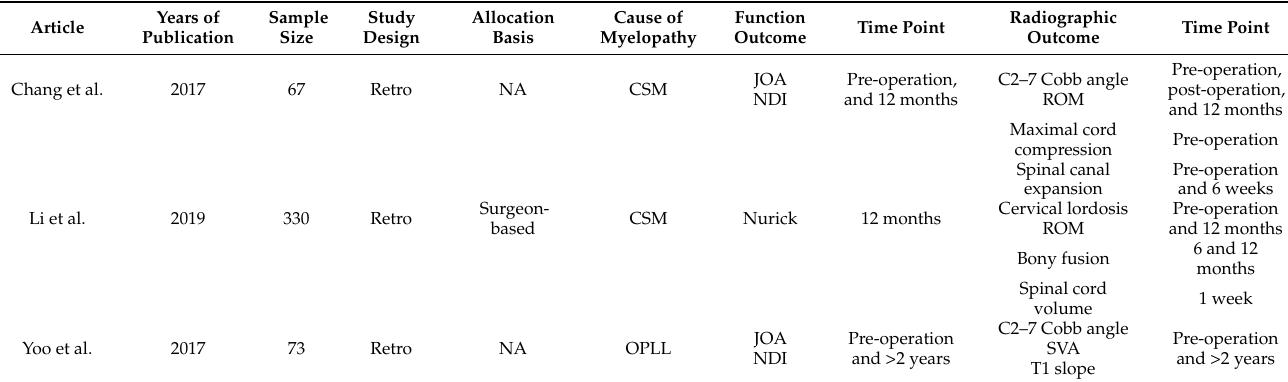
Table 3. Studies describing laminoplasty versus laminectomy